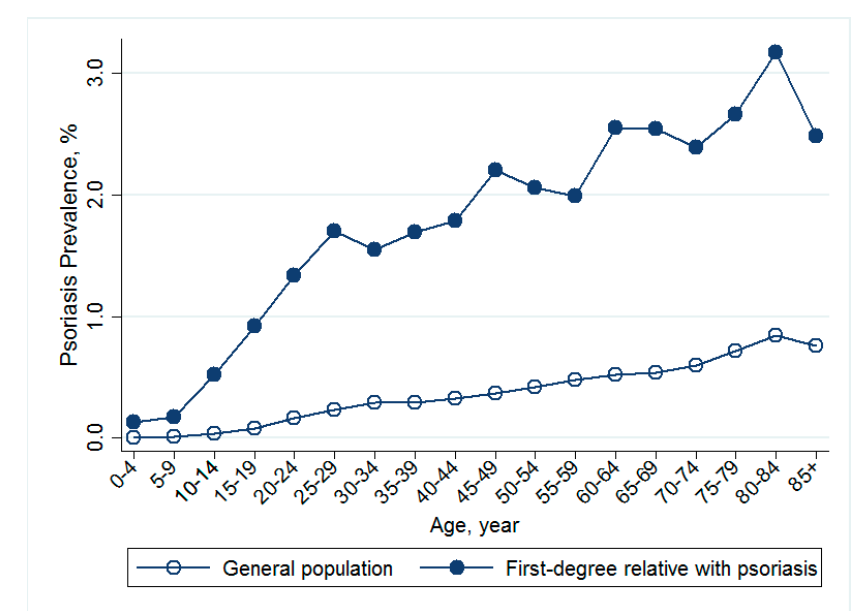
Figure 1. Psoriasis. Age-specific prevalence of psoriasis in individuals with a first-degree relative (circle) with psoriasis and in the general population (hollow circle) in Taiwan in 2010.